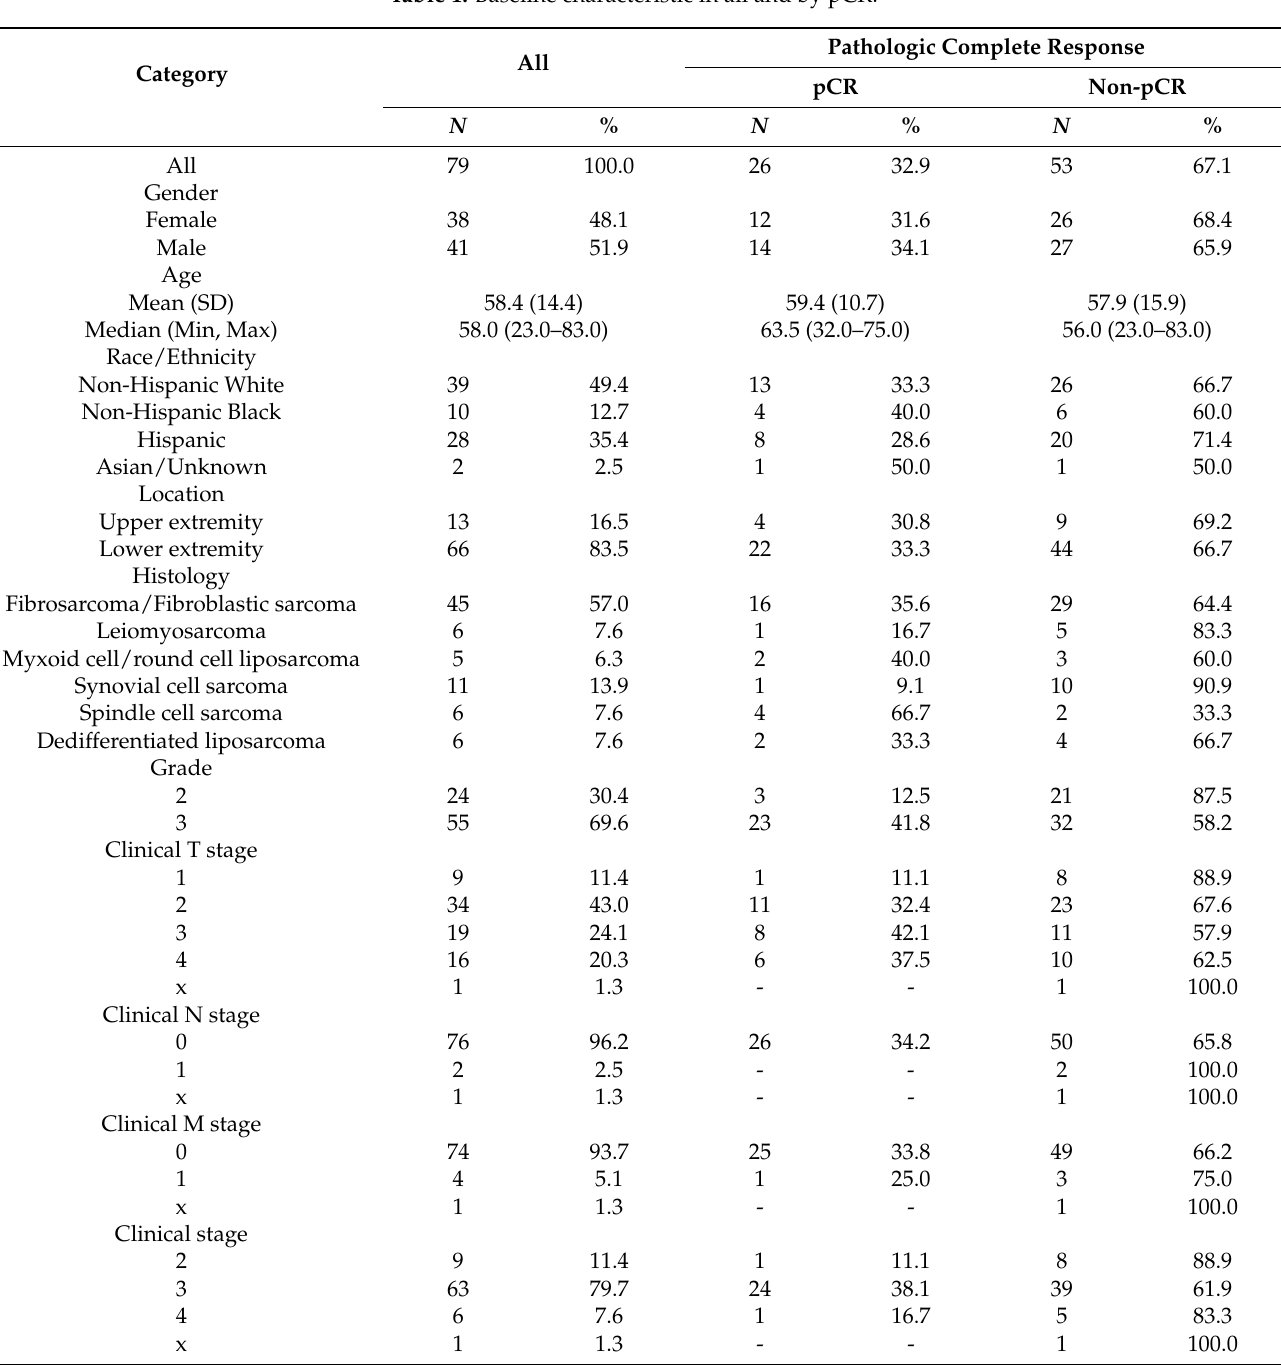
Table 1. Baseline characteristic in all and by